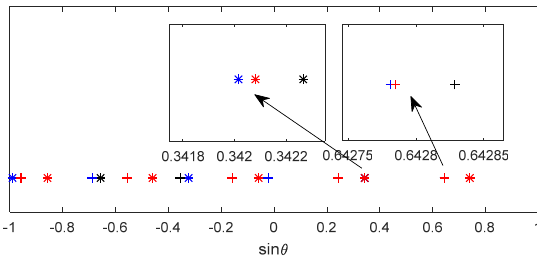
Figure 8. Scatter plot of γ and η .